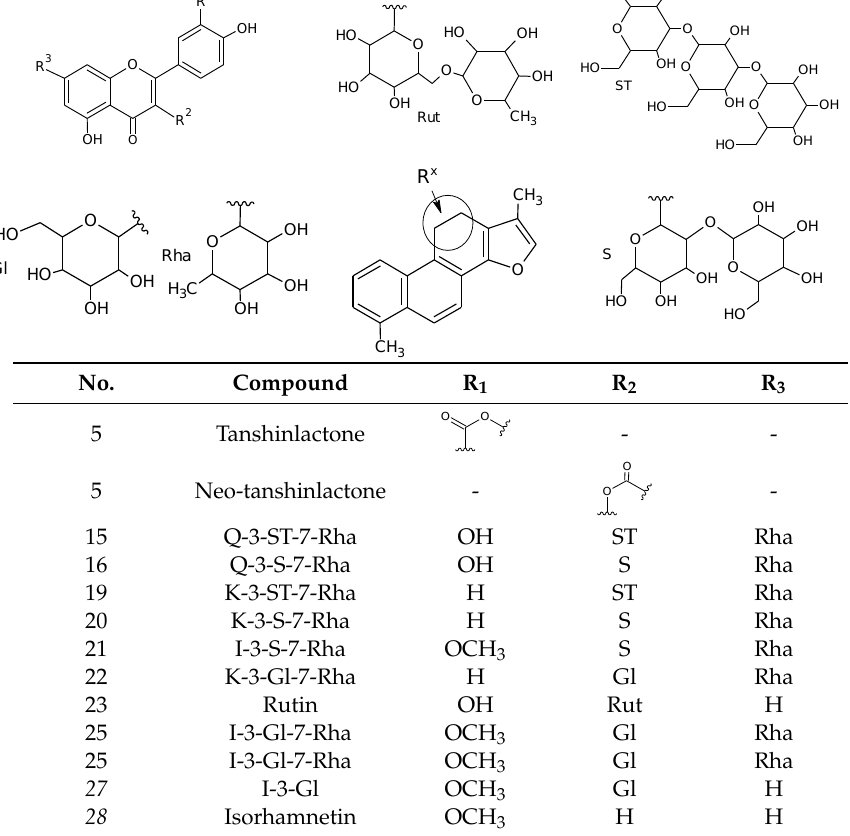
Table 3. Structures of flavonol glycosides and (neo)-tanshinlactone derivative.